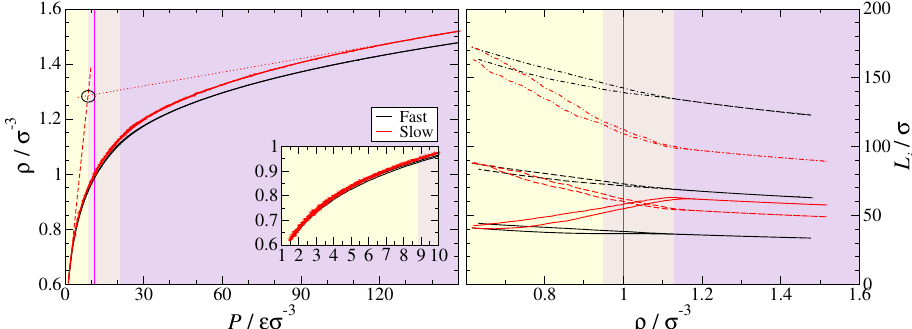
Figure 2. Isothermal curves at T = 1 (cid:101) / k B and pressure rates δ P / δ t = 1.5 · 10 − 2 (cid:101)σ − 3 τ − 1 (black) and δ P / δ t = 3.0 · 10 − 3 (cid:101)σ − 3 τ − 1 (red) obtained by expanding and then compressing between P 1 = 1.5 (cid:101)σ − 3 and P 2 = 150 (cid:101)σ − 3 . The continuous vertical line marks our system’s pressure P = 11.3 (cid:101)σ − 3 and density ρ = 1.0 σ − 3 (magenta). ( Left ) Pressure vs. density plane. It contains the isotherms (continues lines) and linear regressions of the slow-rate curve at each end (dashed and dotted red lines). Their intersection ( P = 8.82 (cid:101)σ − 3 , ρ = 0.95 σ − 3 ) distinguishes isotropic (light yellow area) from lamellar (yellow-purple mixed-coloured and purple areas) phases. The inset shows the same results in the low-density region. ( Right ) Box dimensions vs. density plane. It displays evolution of L x (dashed lines), L y (dashed-dotted lines) and L z (continuous lines) at the two pressure rates. An abrupt change in δ L i / δρ is observed at ρ = 1.13 σ − 3